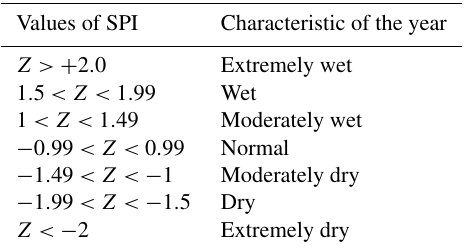
Table 1. The intervals of the SPI index values for identifying rain- fall anomalies (from Shah et al., 2015). Values of SPI Characteristic of the year Z > + 2 .